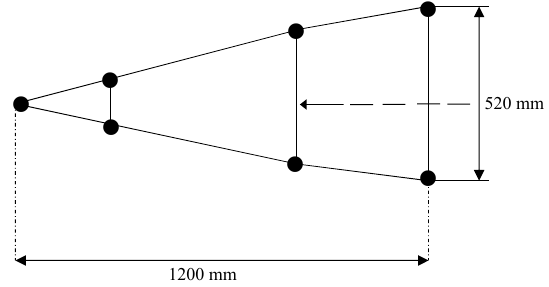
Figure 10. The size and the shape of the conical target.